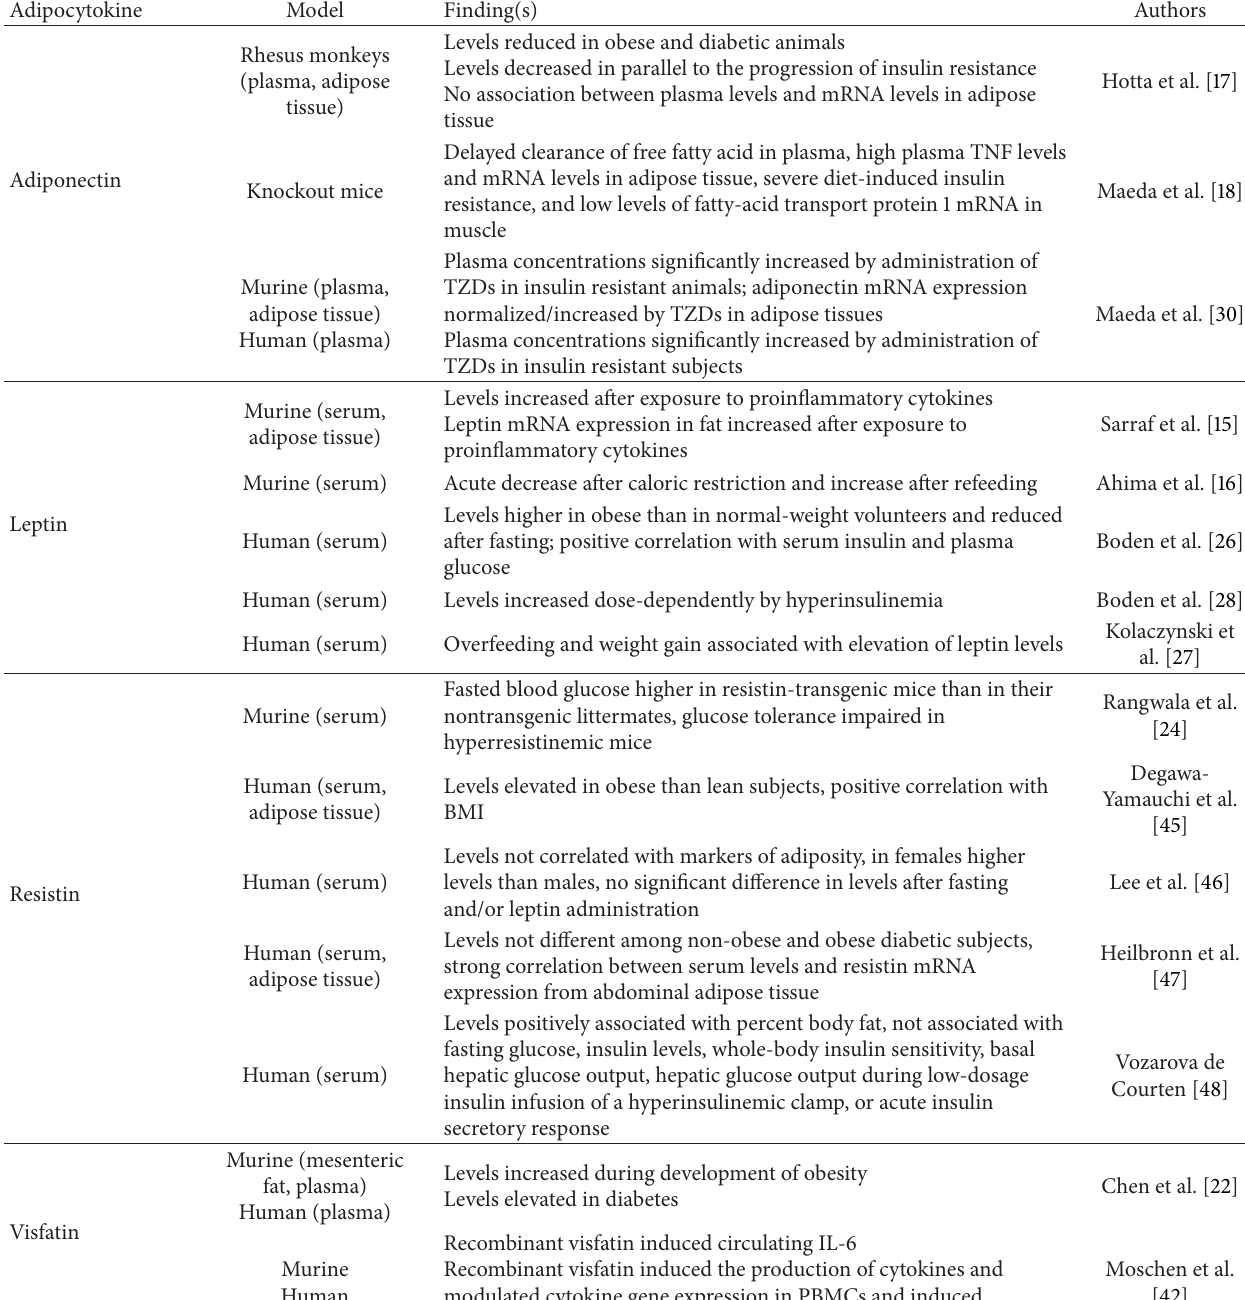
Table 1: Overview of main experimental and clinical data on adipocytokines in